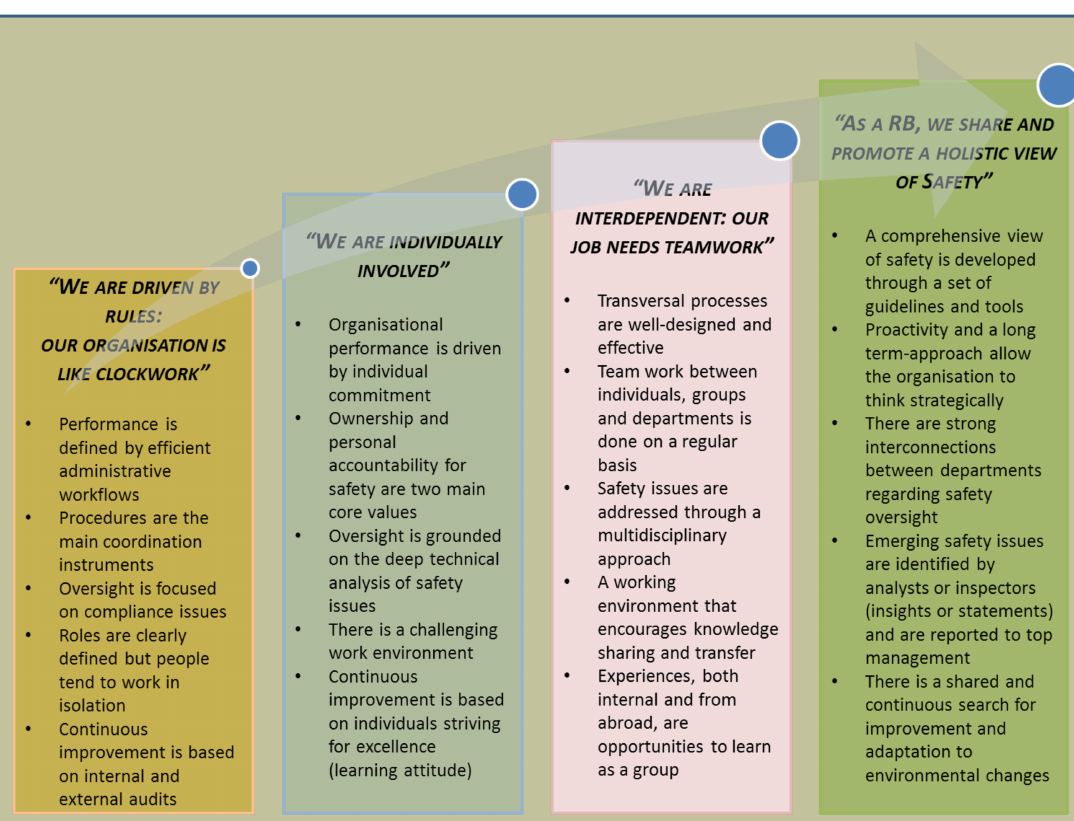
Figure 1. The four levels of the Safety Culture Maturity